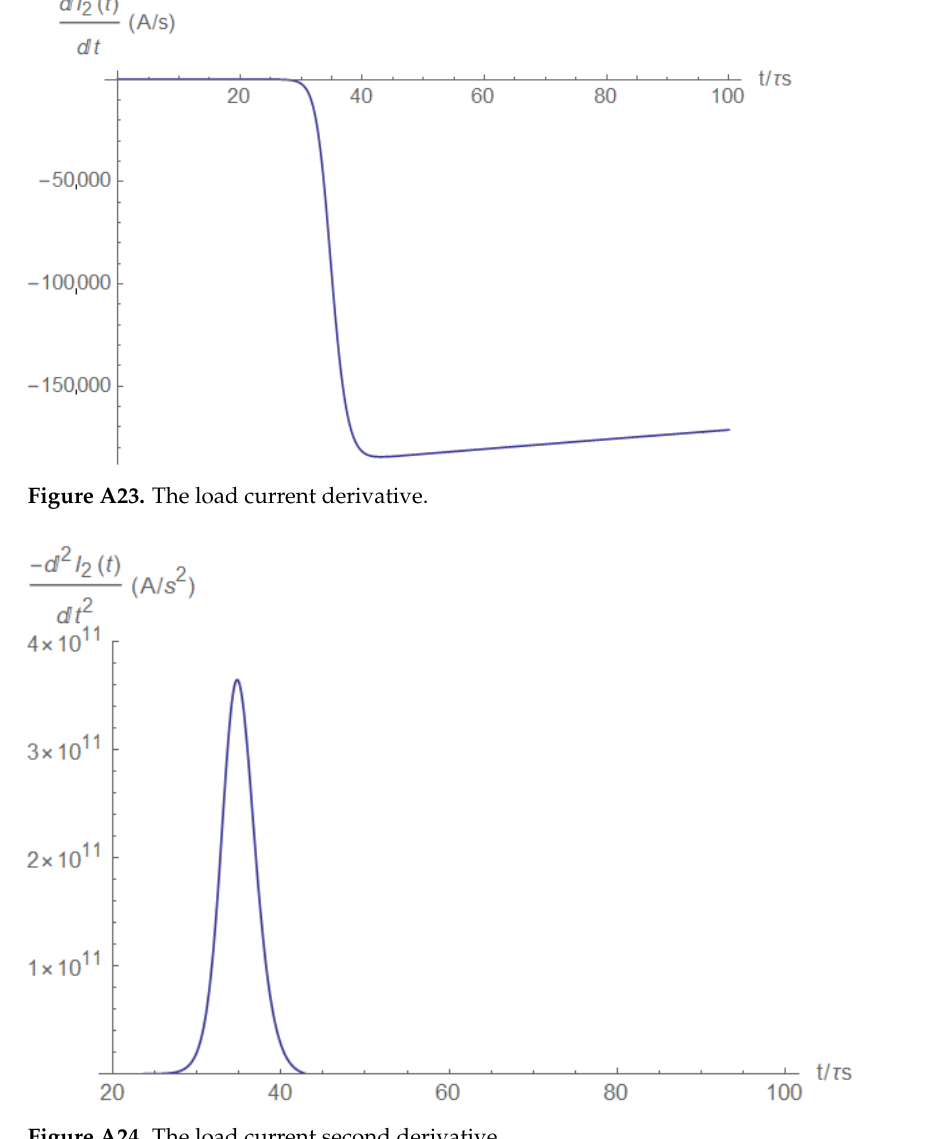
Figure A24. The load current second